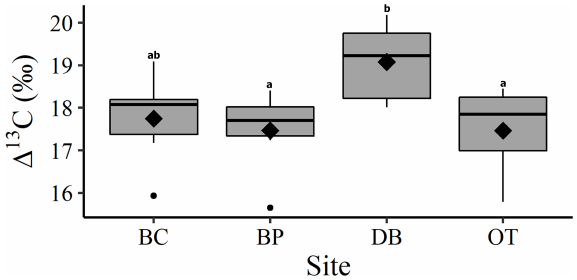
Figure 4. One-way ANOVA and Tukey post hoc analysis (denoted with letters) for mean difference in site-level tree ring (cid:49) 13 C aver- aged over the 40-year period. Black diamonds indicate mean values, horizontal black lines indicate median values, black circles indicate outliers and gray boxes show values lying between the upper and lower